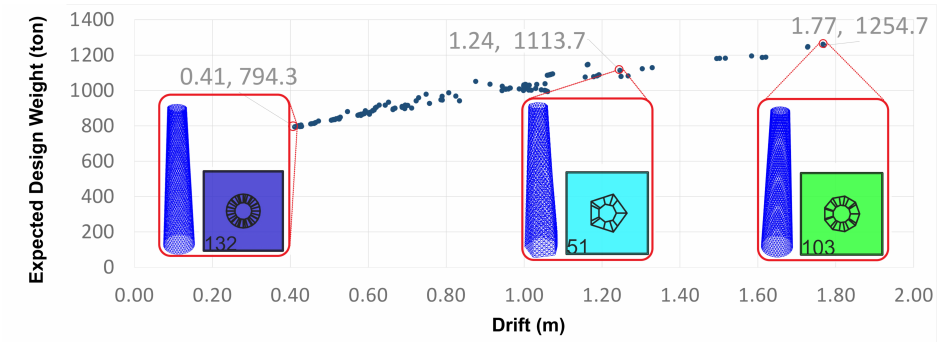
Figure 4. Expected design weight vs drift plot, with insets reporting the geometries of the forms featuring the best, average and worst